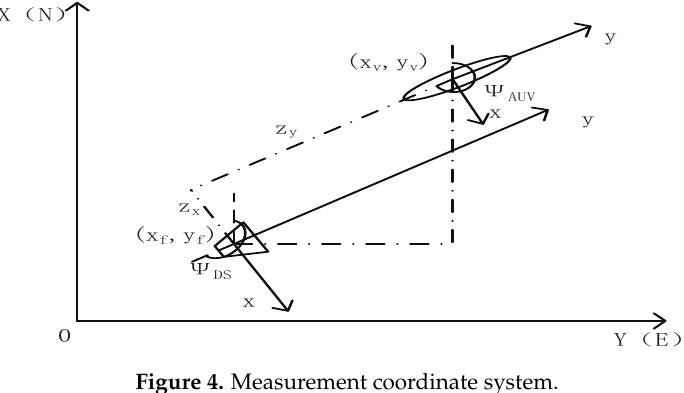
Figure 4. Measurement coordinate